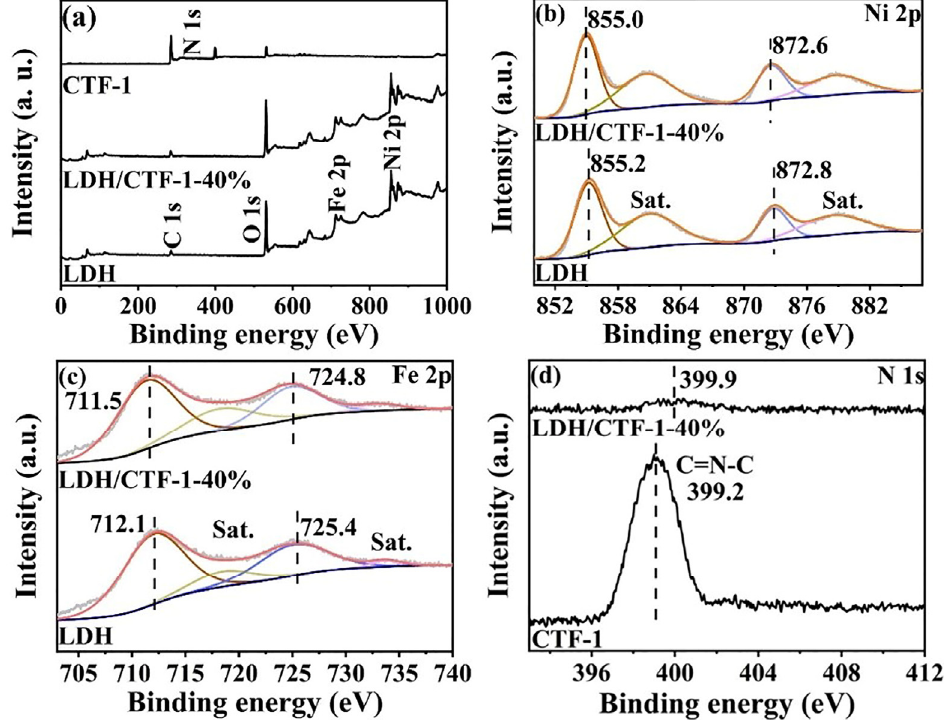
Figure 3. ( a ) XPS survey spectra, high-resolution X-ray photoelectron spectra in ( b ) Ni 2p; ( c ) Fe 2p; and ( d ) C 1s regions of LDH, CTF-1, and LDH/CTF-1-40%. and ( d ) C 1s regions of LDH, CTF-1, and